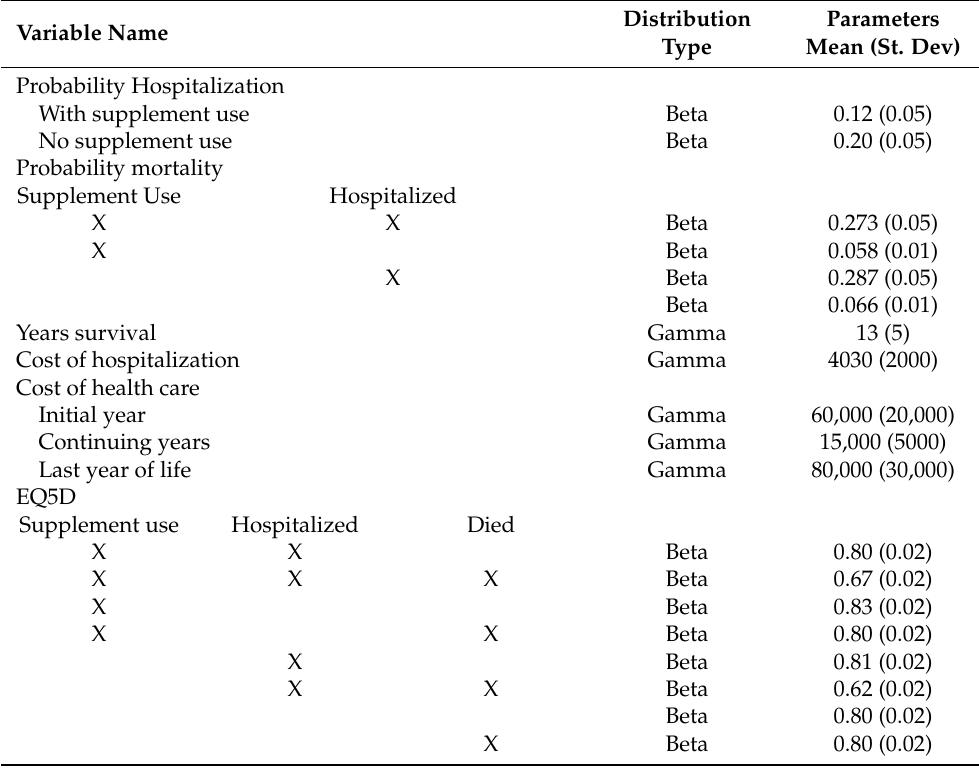
Table 2. Distributions and parameters for the probabilistic sensitivity